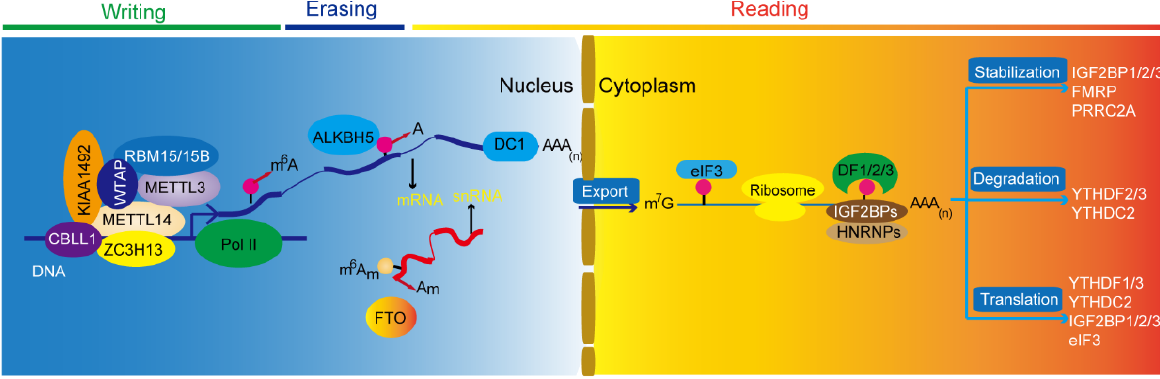
Figure 1. m 6 A modification determines RNA life fate. Here, is the cycling model of methyltransfer- ase complex, demethylase, and m 6 A binding proteins. A, adenosine; m 6 A, N 6 -methyladenosine; m 6 Am, N 6 , 2 ′ -O-dimethyladenosine; Am, 2 ′ -O-methyladenosine; snRNA, small nuclear RNA; m 7 G, N 7 -methylguanosine; AAA (n), polyadenylation.